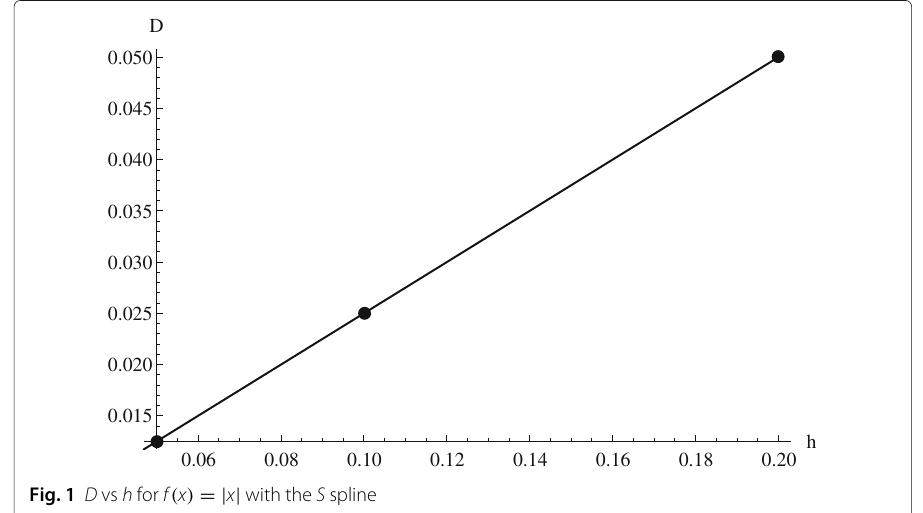
Fig. 1 D vs h for f ( x ) = | x | with the S